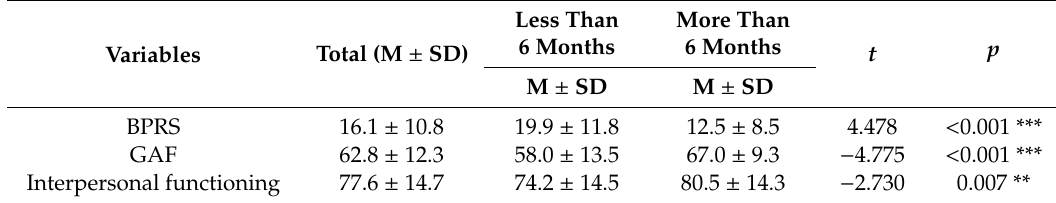
Table 2. Participants’ clinical